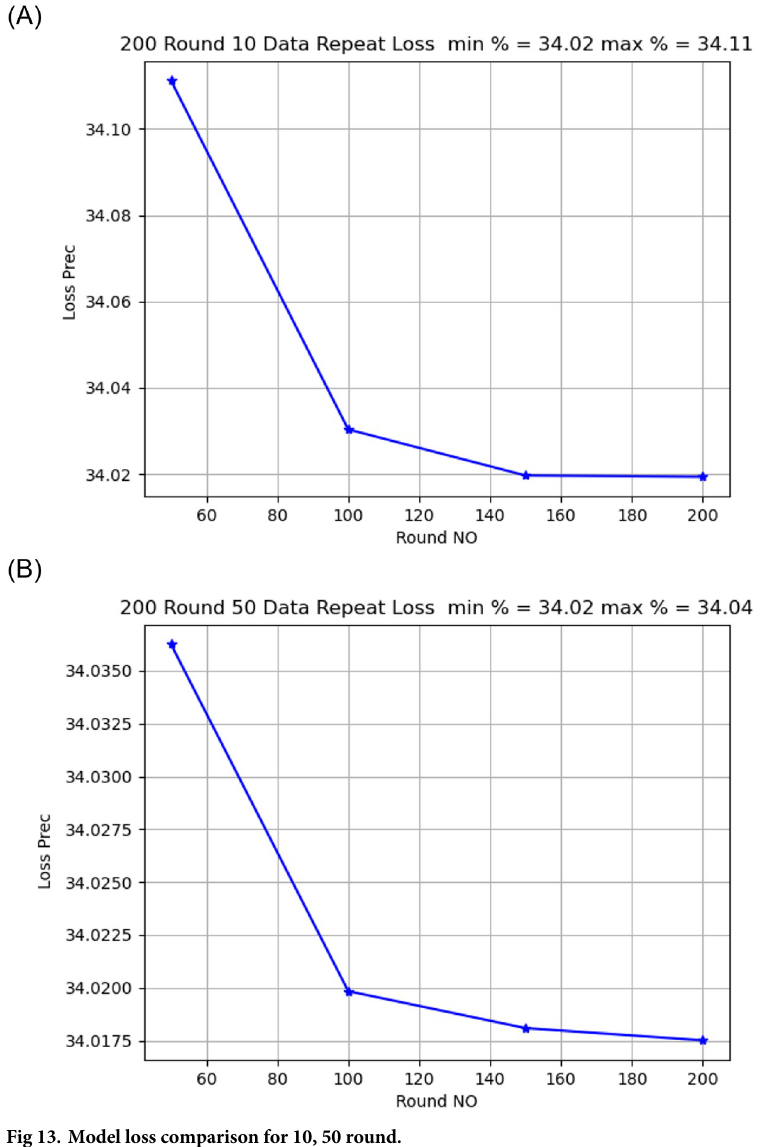
Fig 13. Model loss comparison for 10, 50